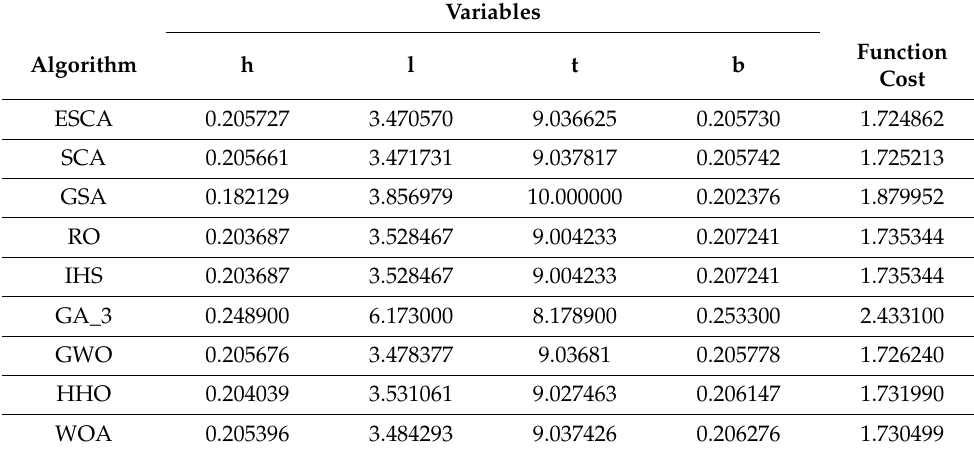
Table 26. Welded beam problem. Function cost and